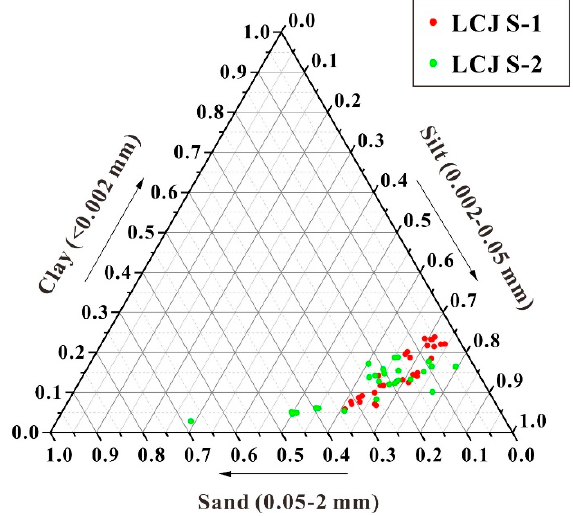
Figure 3. Vertical distribution of soil pH ( a ) and C/N ratios ( b ) in soil profiles. (SON contents of some soil samples were lower than the instrument detection limit, so some C/N ratios weren’t obtained).